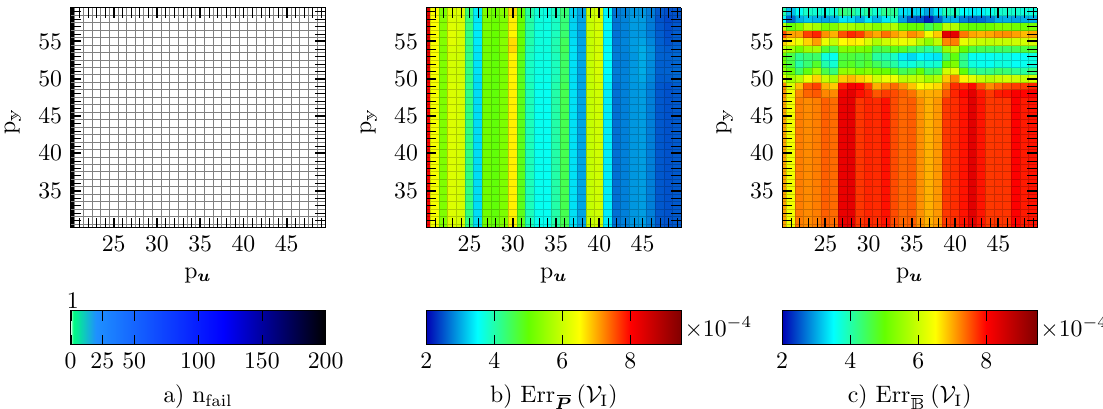
Figure 7. Influence of gappy point numbers p u and p y on ( a ) robustness and ( b , c ) accuracy for a reduced basis of size n u = 20 and n y = 10 using r u = 36 and r y = 24 residuum modes.